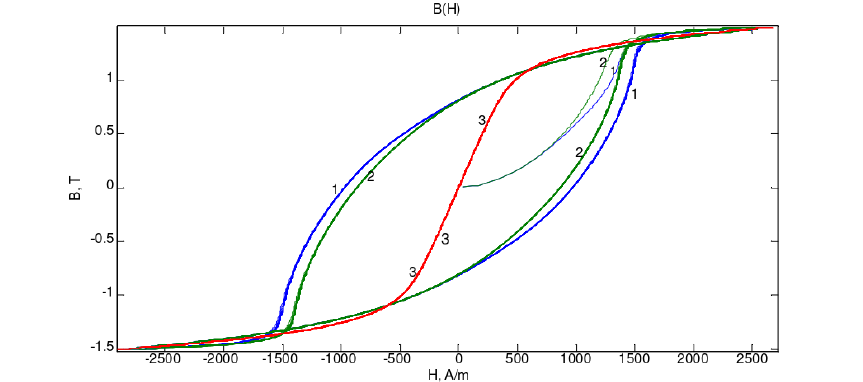
Figure 4. The dependence of the magnetic magnetic flux density B on the strength of the magnetic field H at frequency f = 1500 Hz; 1—the curve including losses of eddy current and hysteresis, 2—the curve including only eddy current losses, 3—the primary magnetization curve (10)